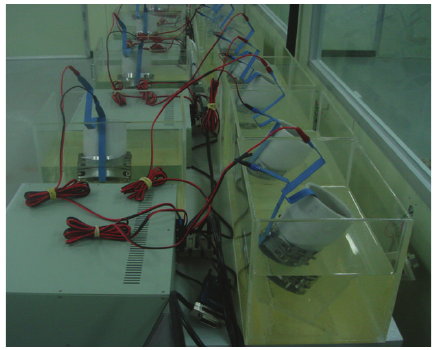
Figure 7: Chloride migration test.